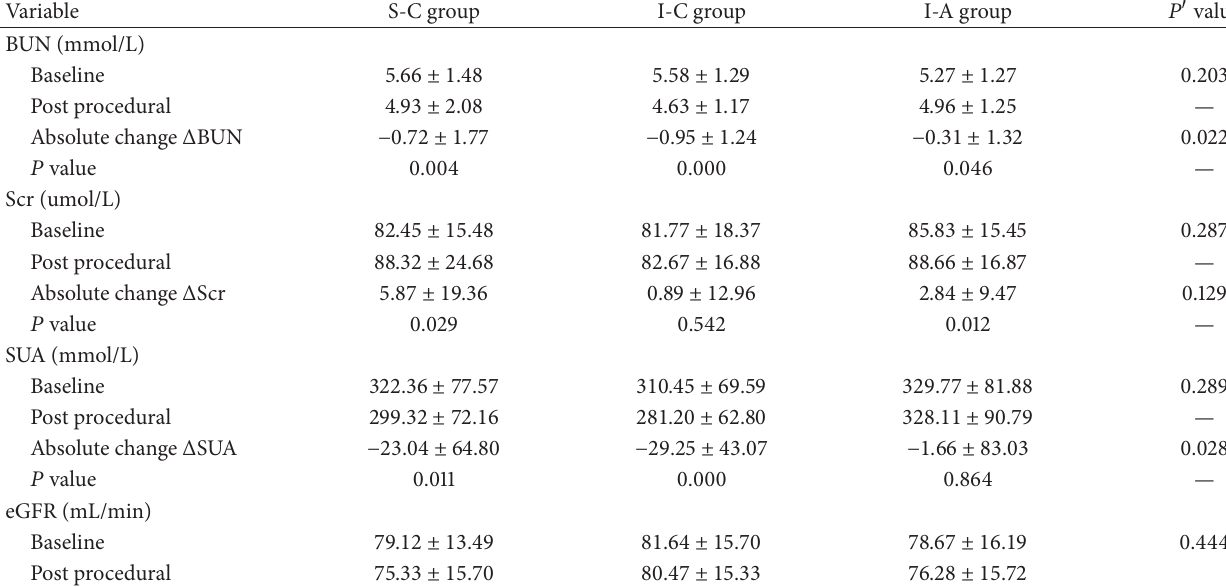
Table 2: Comparison of serum BUN, Scr, SUA and eGFR levels at baseline and 24 hours after